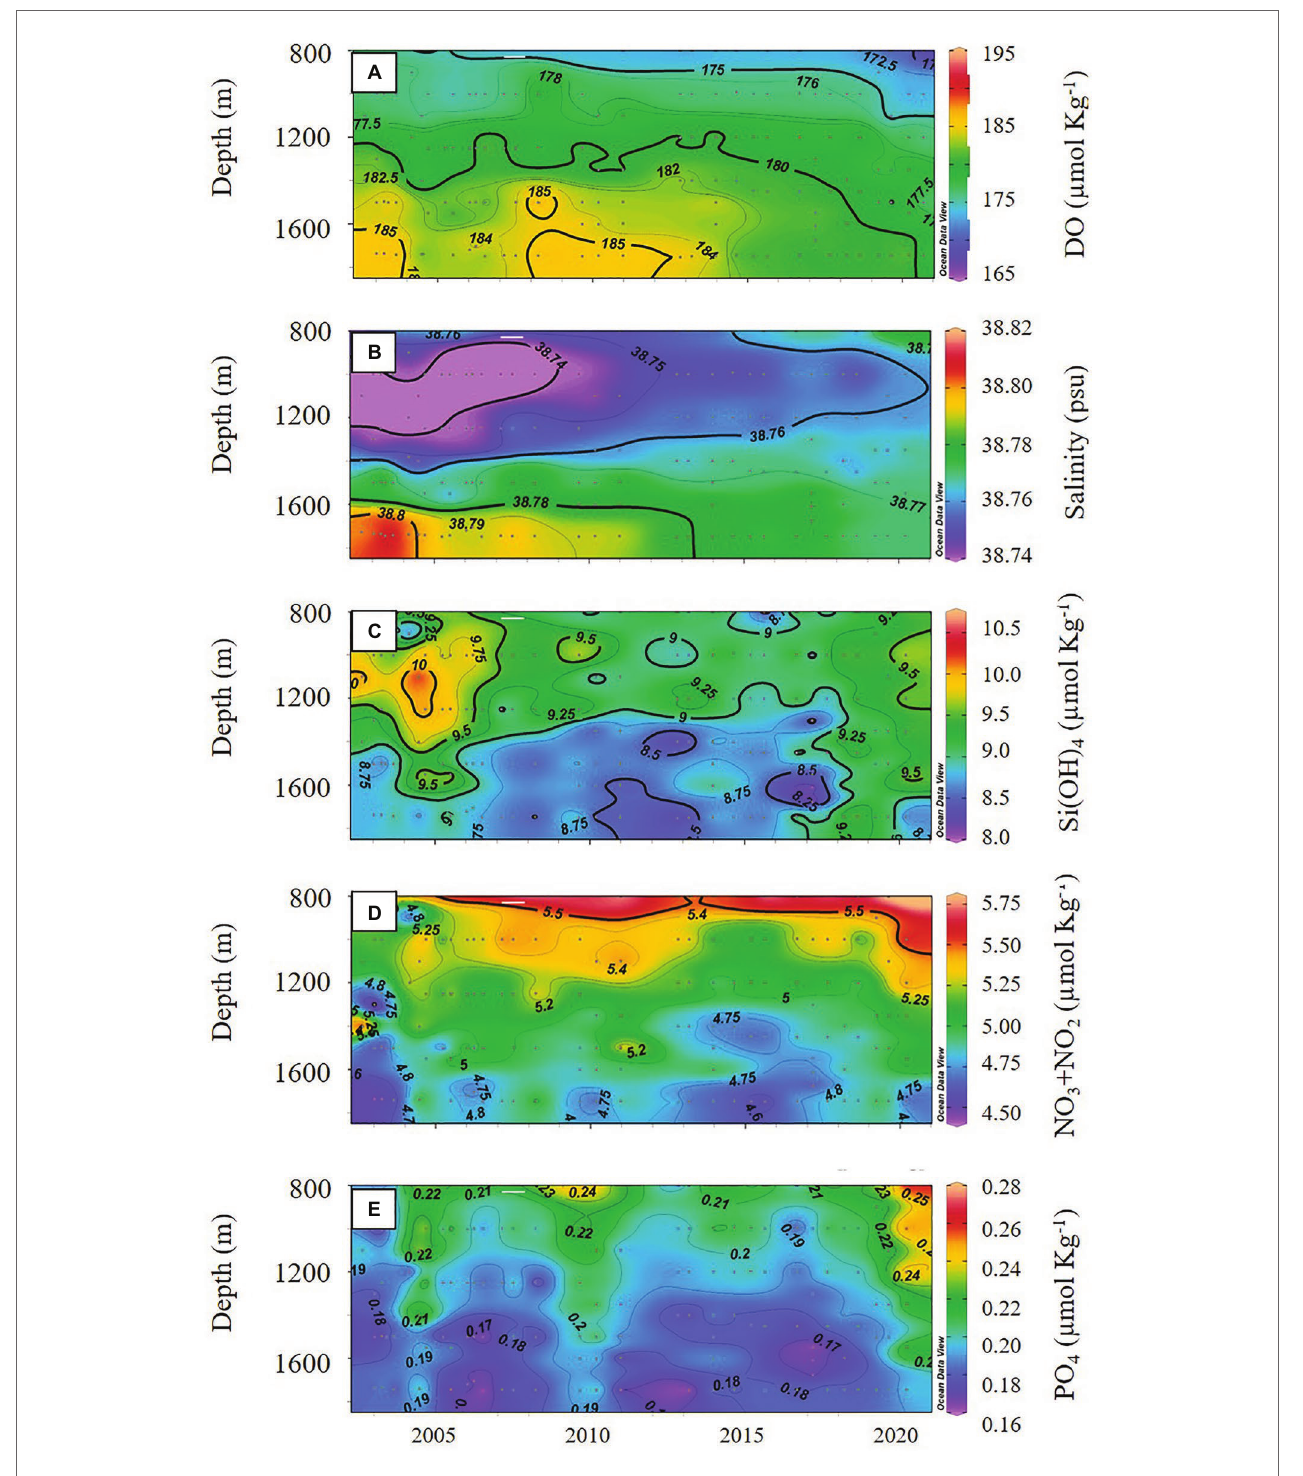
FIGURE 3 | Temporal variation in: (A) oxygen, (B) salinity, (C) Si(OH) 4 , (D) NO 3 + NO 2 (NOx), and (E) PO 4 , measured in the deep layer (1200–1750 m) at station